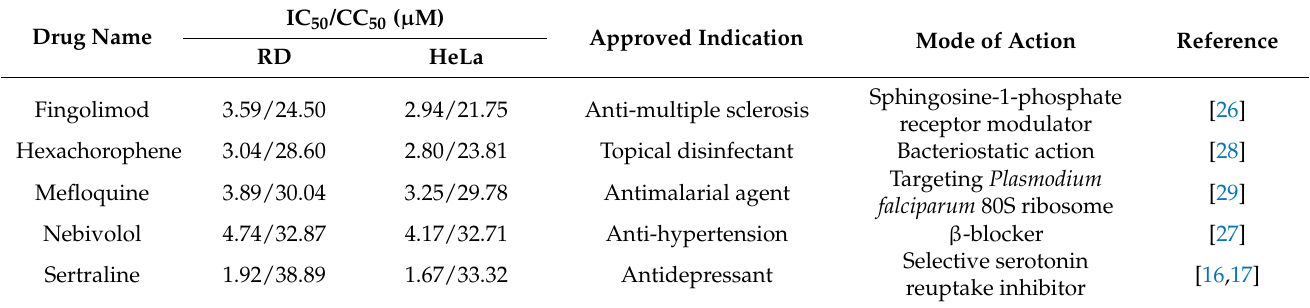
Table 1. Antiviral Potency of the Hits, and Their Approved Indications and the Associated Modes of